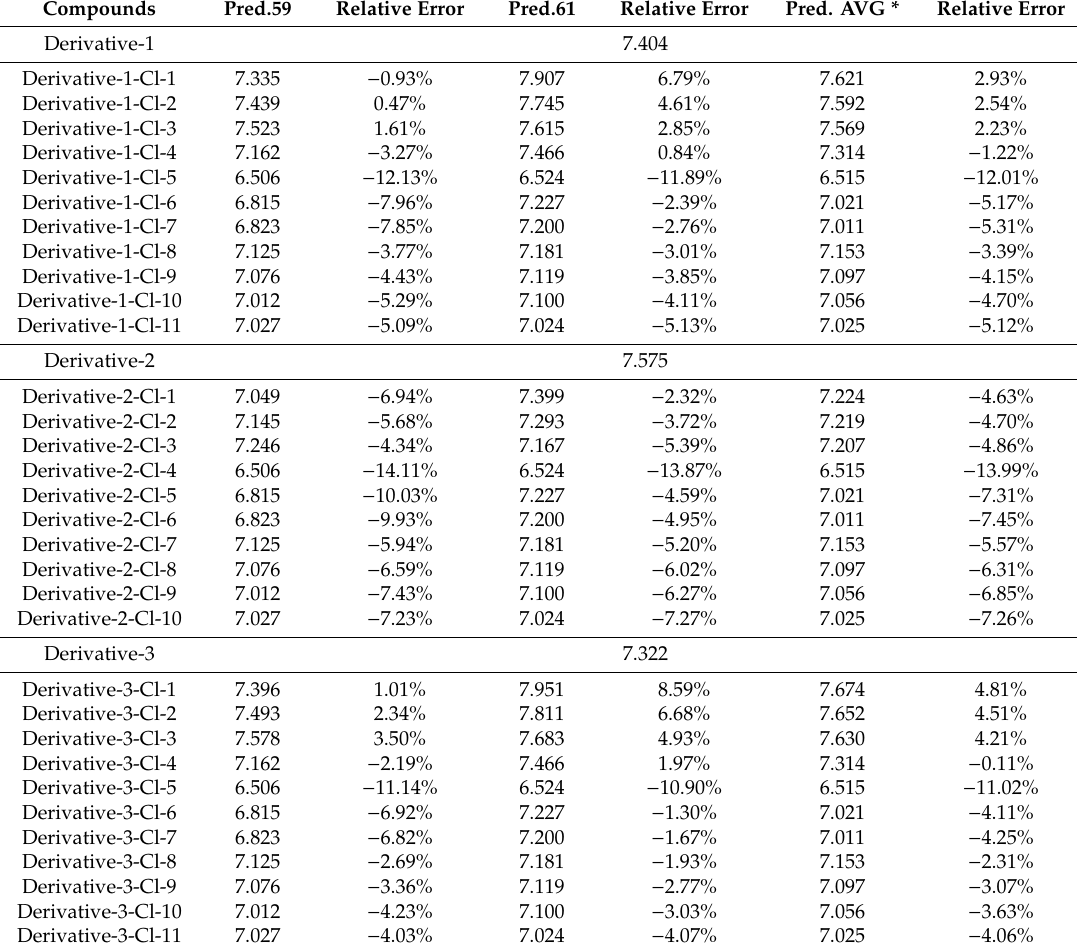
Table 10. Risk assessment of genotoxicity of disinfection by-products of PAZ